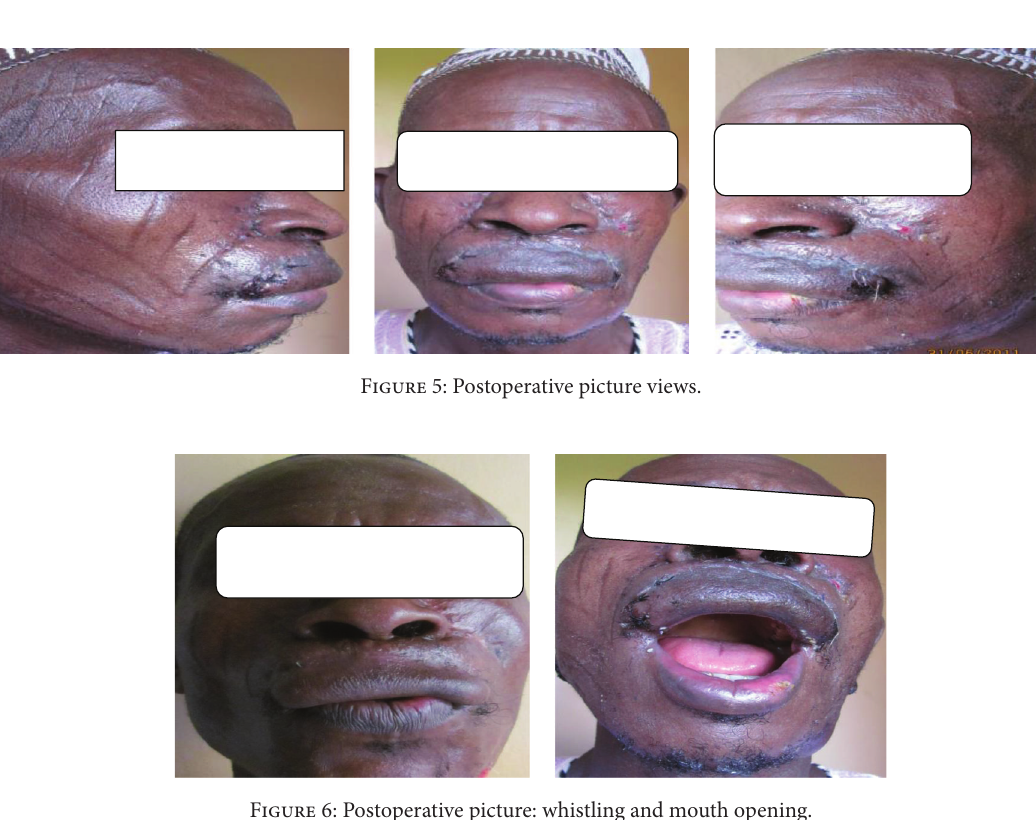
Figure 4: Submental flap lined with mucosal graft.